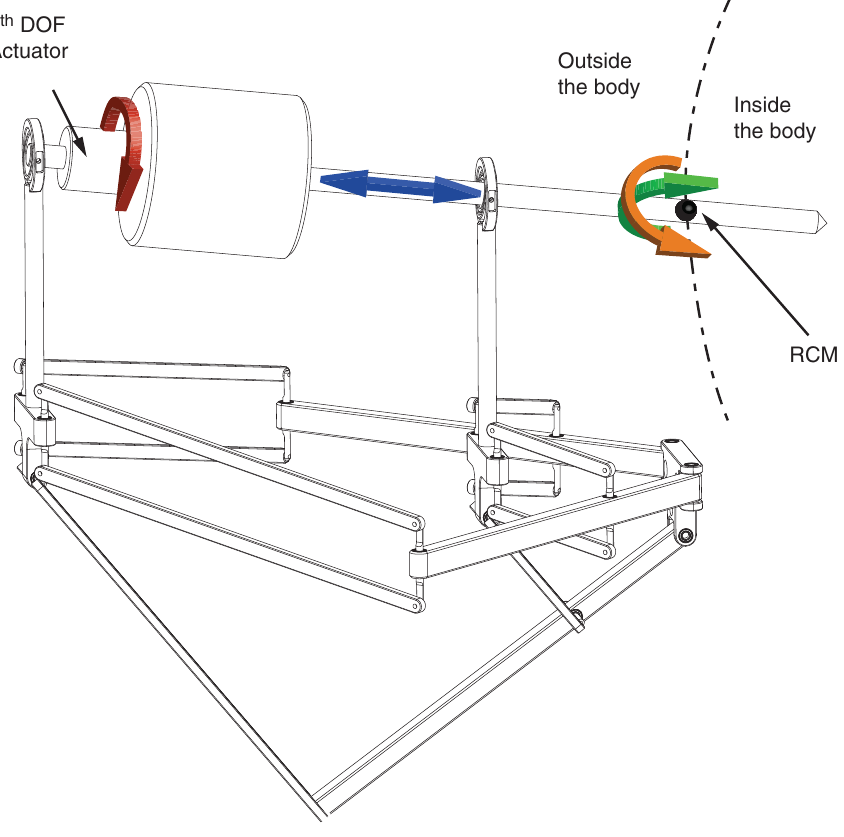
Fig. 4. Degrees of freedom of the external